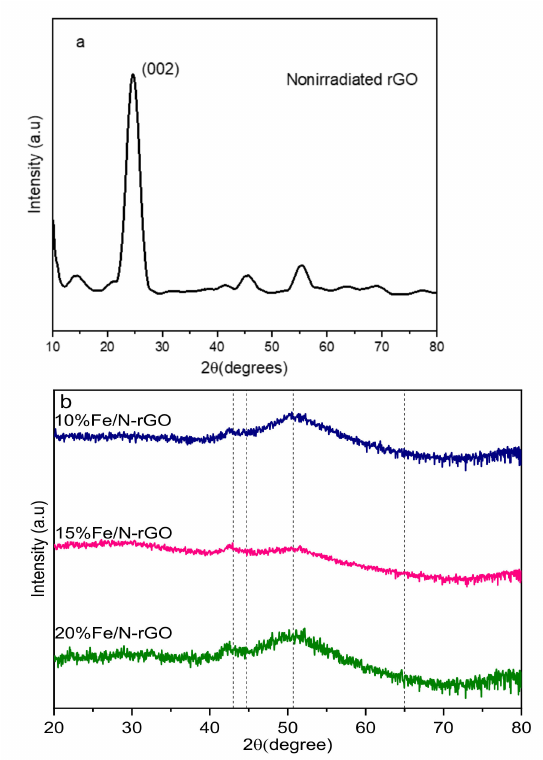
Figure 1. ( a ) X-ray diffraction (XRD) patterns of reduced graphene oxide (rGO) (before irradiation) and ( b ) 10% Fe/N-rGO, 15% Fe/N-rGO and 20%